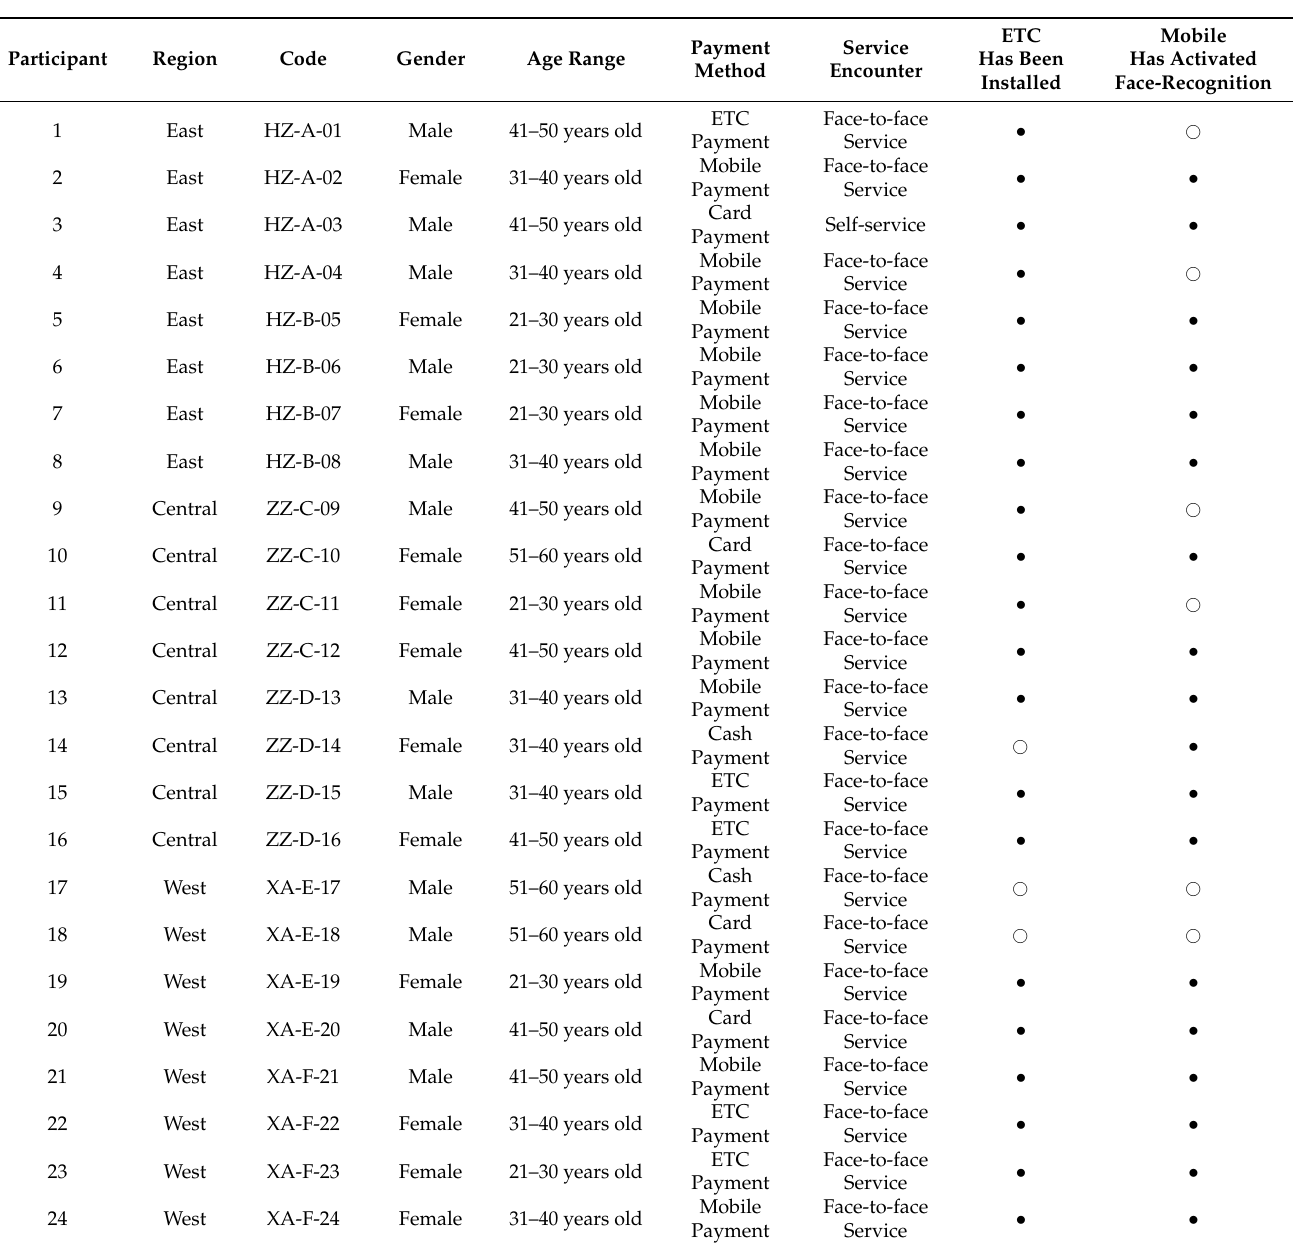
Table 5. Interview information and